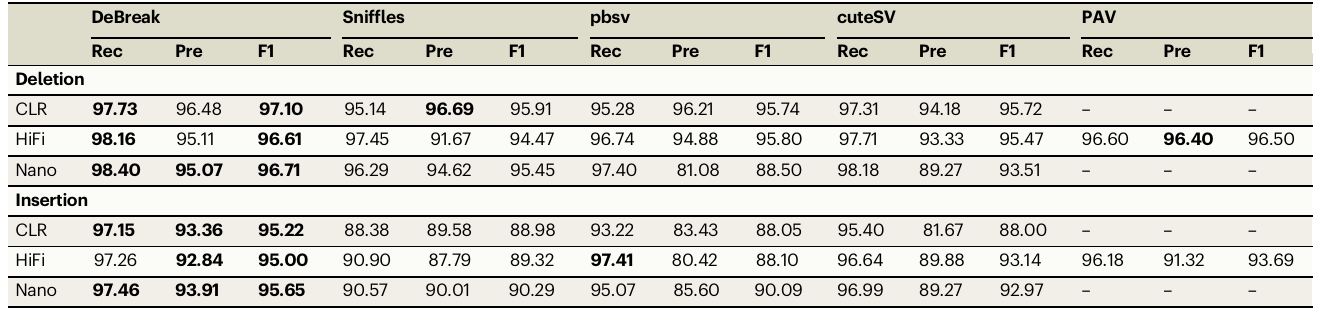
Table 2 | SV discovery accuracy on